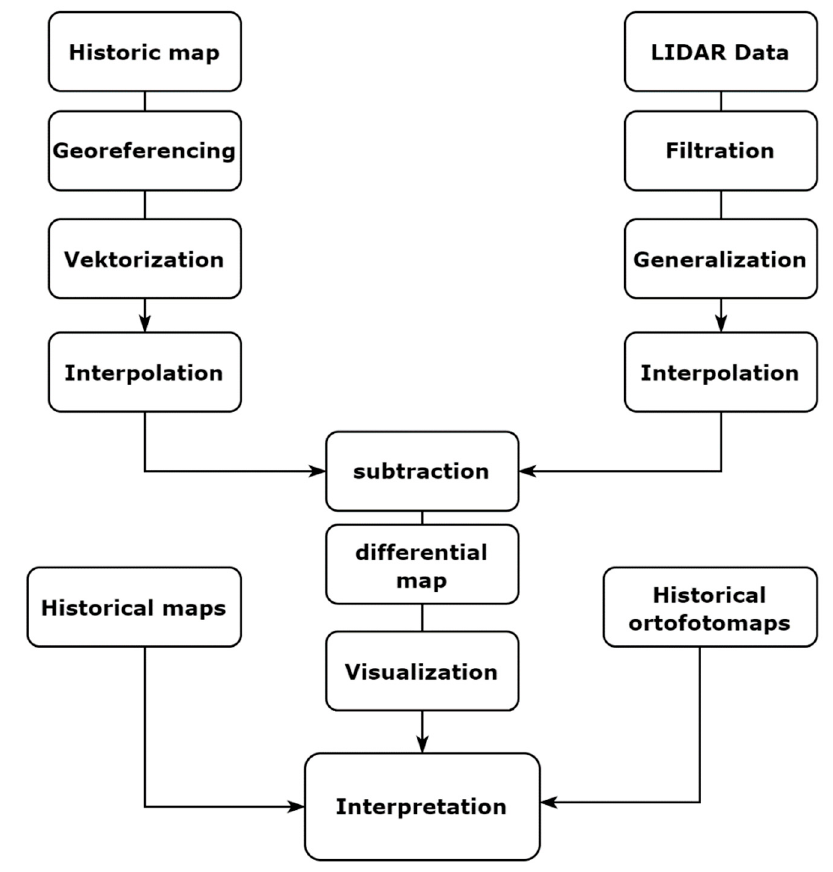
Figure 4. Research procedure diagram.